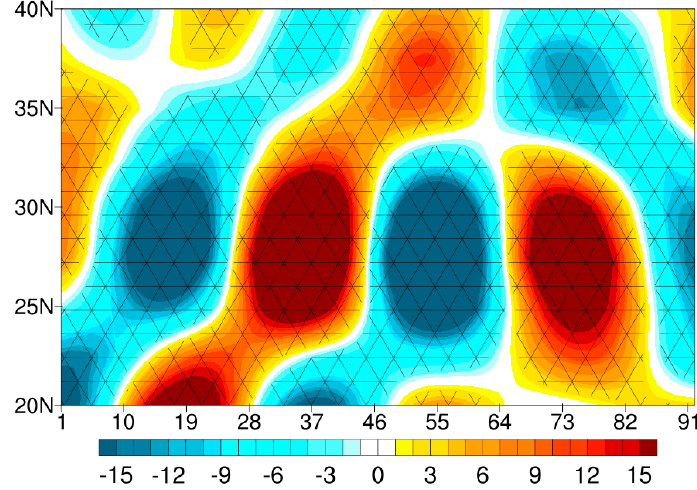
Figure 11. Time-longitude profile of OLR along 105° to 130° E in 1998.